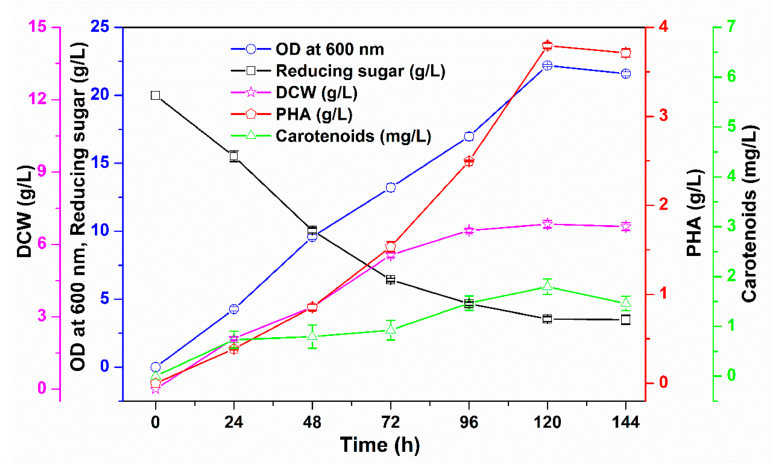
Figure 3. Time profile of OD at 600 nm, DCW, PHA accumulation, carotenoid production, and substrate utilization by Haloferax mediterranei DSM 1411 using 0.3 N HCl DCB hydrolysate as the carbon source in a flask culture. Data are shown as mean values ± standard deviation ( n = 3).